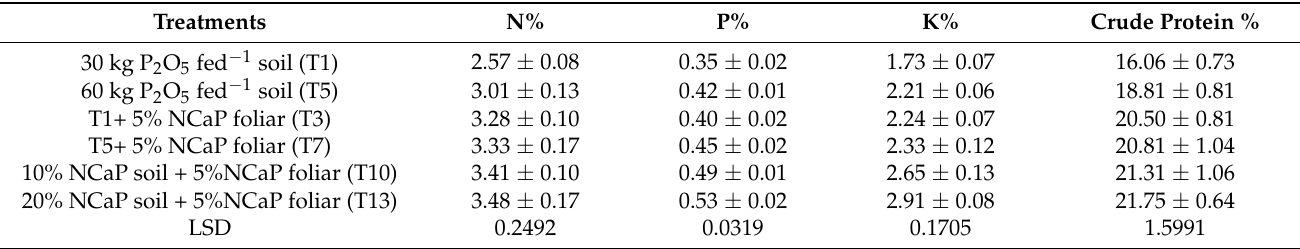
Table 7. Effect of different phosphorus treatments on the nutrient concentration (N, P and K) and crude protein percentage in pods of snap bean